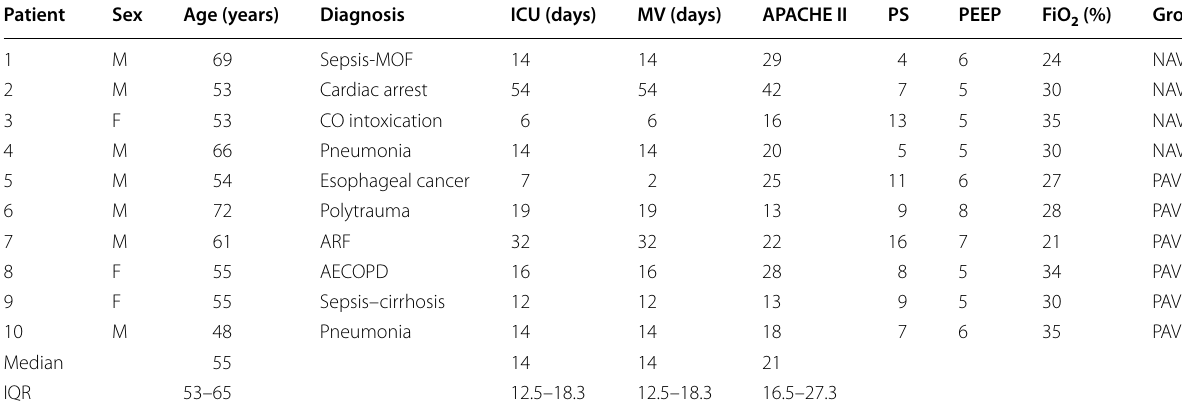
Table 1 Patient characteristics